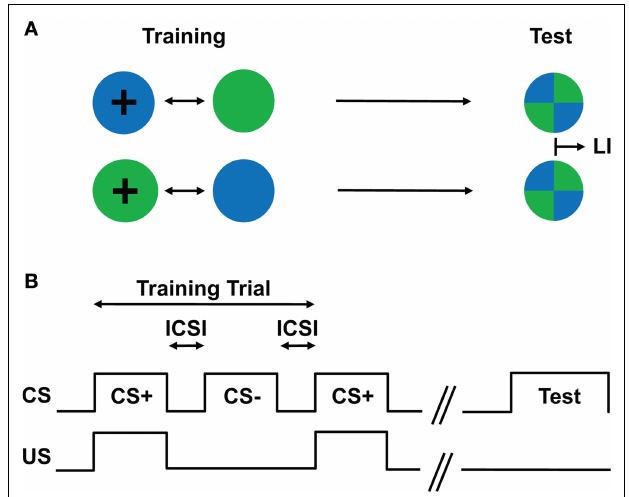
FIGURE 3 | Conditioning design. (A) Schematic drawing of the training and test situations. Two groups of fl ies are trained with different CS/US contingency: one group of fl ies is trained such that green light is paired with a US, whereas blue light is presented without any reinforcing stimulus (i.e., Green + /Blue − ; fi rst row); another group of fl ies is trained with the reversed contingency, i.e., Blue + /Green − (second row). After such training, fl ies are allowed to choose between the previously reinforced (CS + ) and the non- reinforced stimulus (CS − ). The difference of the stimulus preferences of the two groups in the test provides a measure of their memory (LI). (B) Conditioning protocol. After a pre-training period of 60 s, two differential visual stimuli (CS) were sequentially presented for 60 s with an inter-CS interval (ICSI) of typically 10–12 s. Only one of the two CSs was paired with the US (CS + ) for 60 s. One training trial consisted of a CS + and a CS −